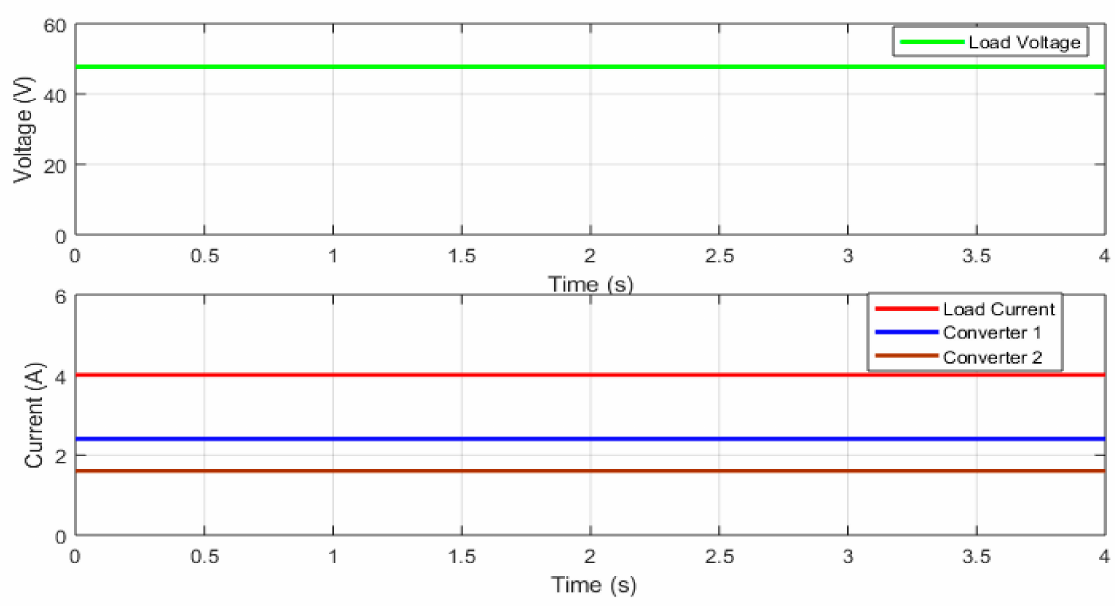
Figure 6. Simulation results for different cable resistances without any droop control: load voltage, converter output currents and load